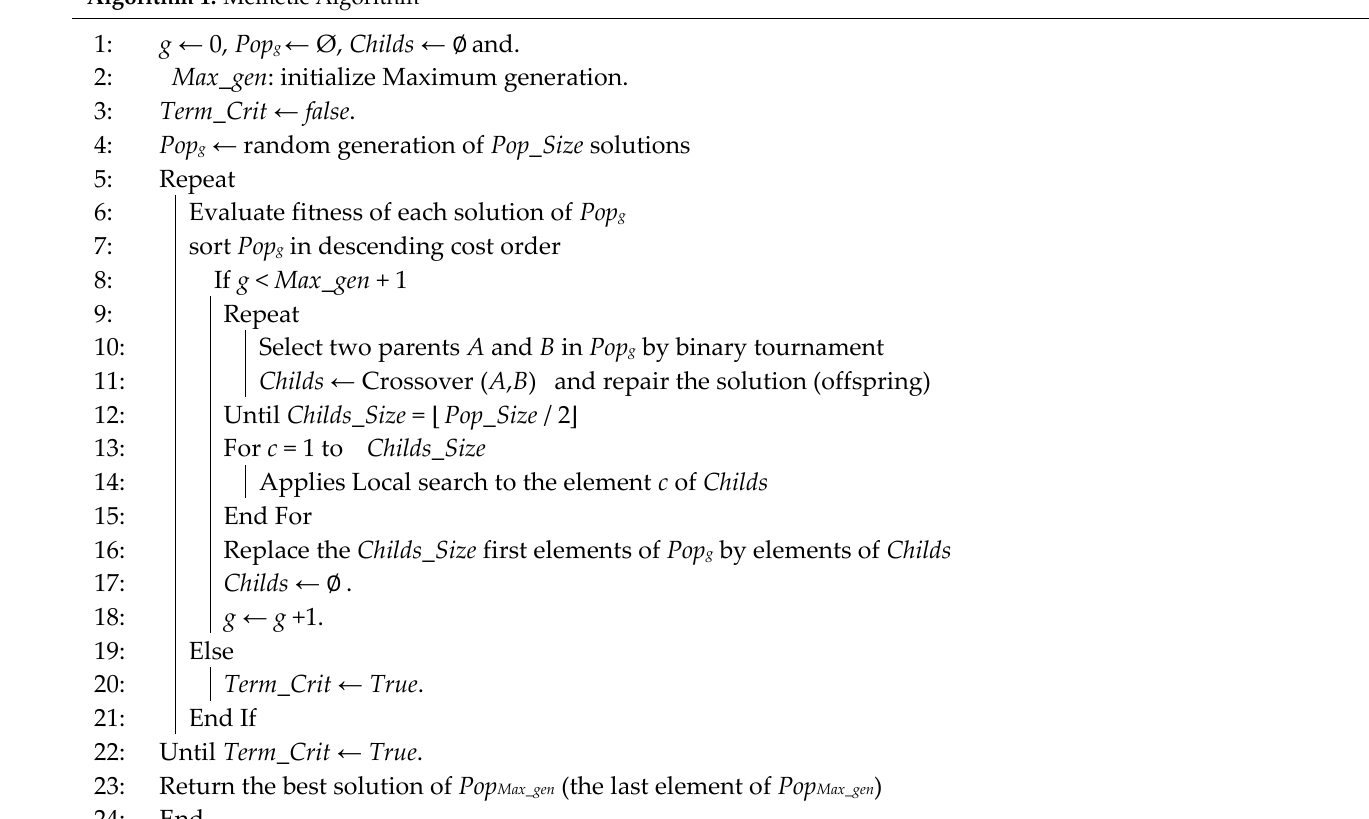
Algorithm 1. Memetic Algorithm